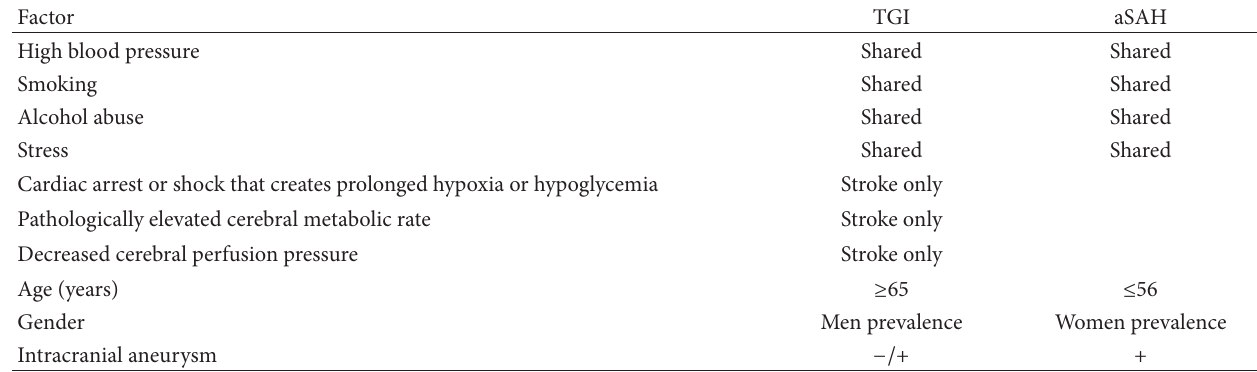
Table 3: Risk factors of TGI versus aneurysmal